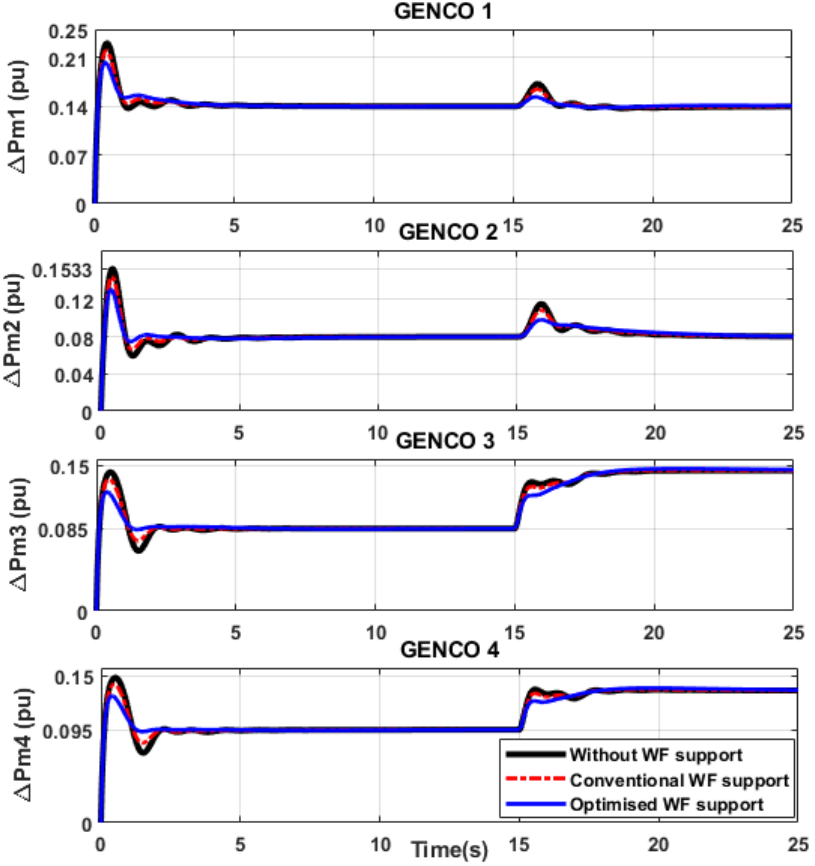
Figure 18. Active power generation of GENCOs in contract violation.